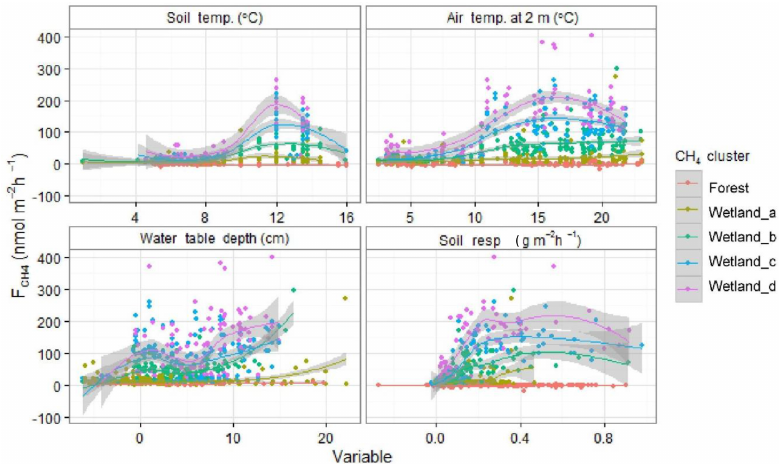
Figure 9. Drivers of temporal variability in CH 4 fluxes, separated by clusters, with shaded area representing loess smoothing. Clusters Wetland_a to Wetland_d represent groups with sequentially increasing CH 4